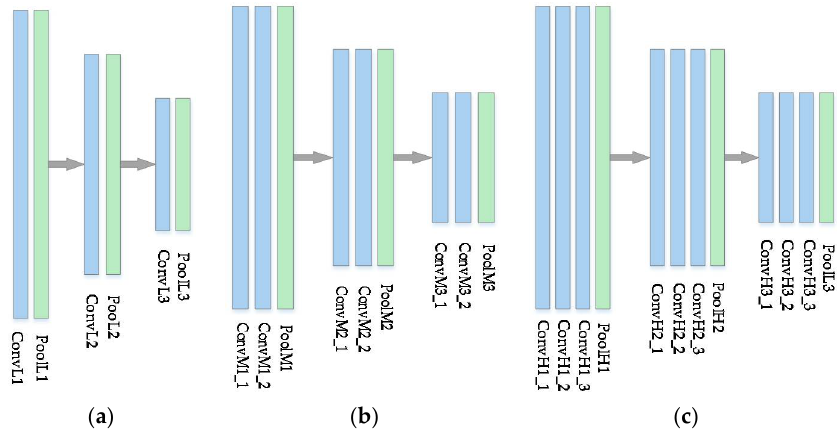
Figure 7. Structure of multi-scale extra branches: ( a ) lightweight branch; ( b ) middleweight branch; and ( c ) heavyweight branch. Table 3. Configurations of convolutional layers in middleweight branch and heavyweight branch. ConvM is convolutional layer of middleweight branch; ConvH is convolutional layer of heavyweight branch.